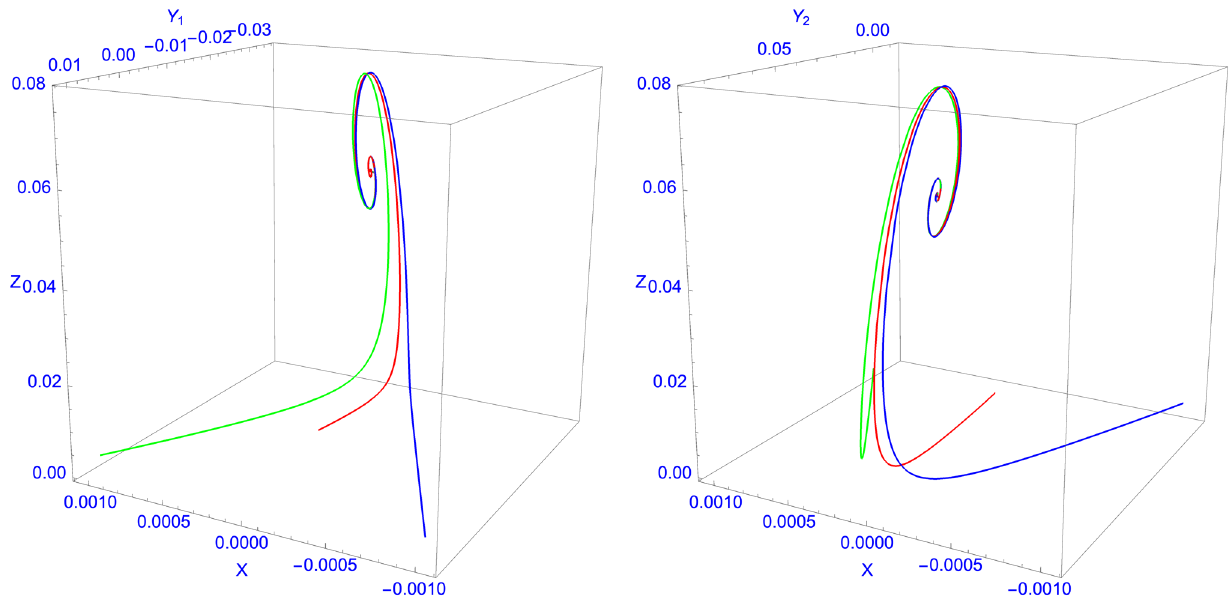
Fig. 1 Attractor behavior of the anisotropic fixed point with ω = + 1, u 0 = 2, λ = 0 . 1, ρ = 50, n = − 0 . 2, and m = − 100. These two plots clearly show that three different trajectories corresponding to different initial conditions all tend to converge to the anisotropic fixed